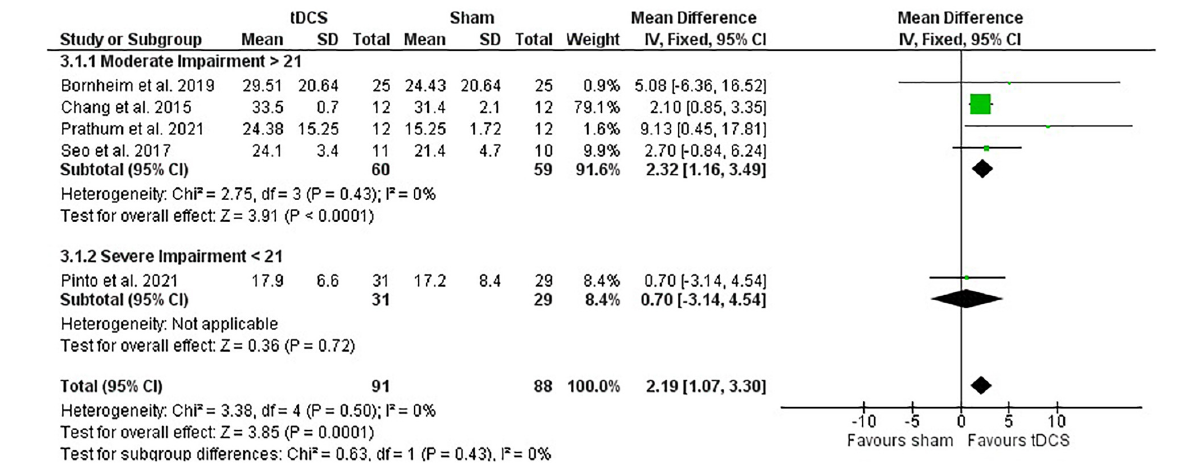
FIGURE 4 | Effects of tDCS on stroke recovery as assessed by the post-intervention data of the tDCS and sham groups for the lower extremity Fugl–Meyer Assessment.